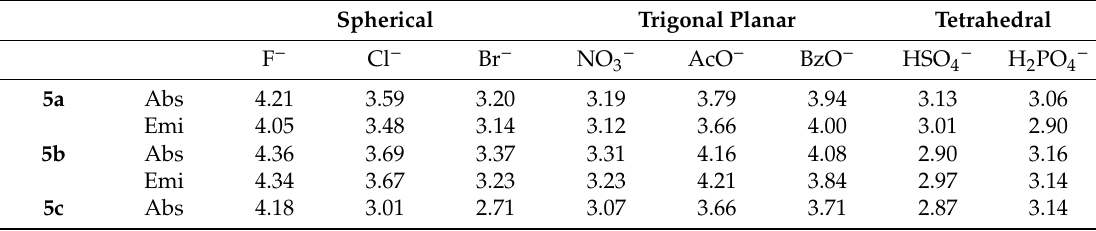
Table 4. Association constants (log K ass ) a of dihomooxa naphthyl(thio)ureas 5a – 5c in C H 2 Cl 2 at 25 ◦ C. Spherical Trigonal Planar